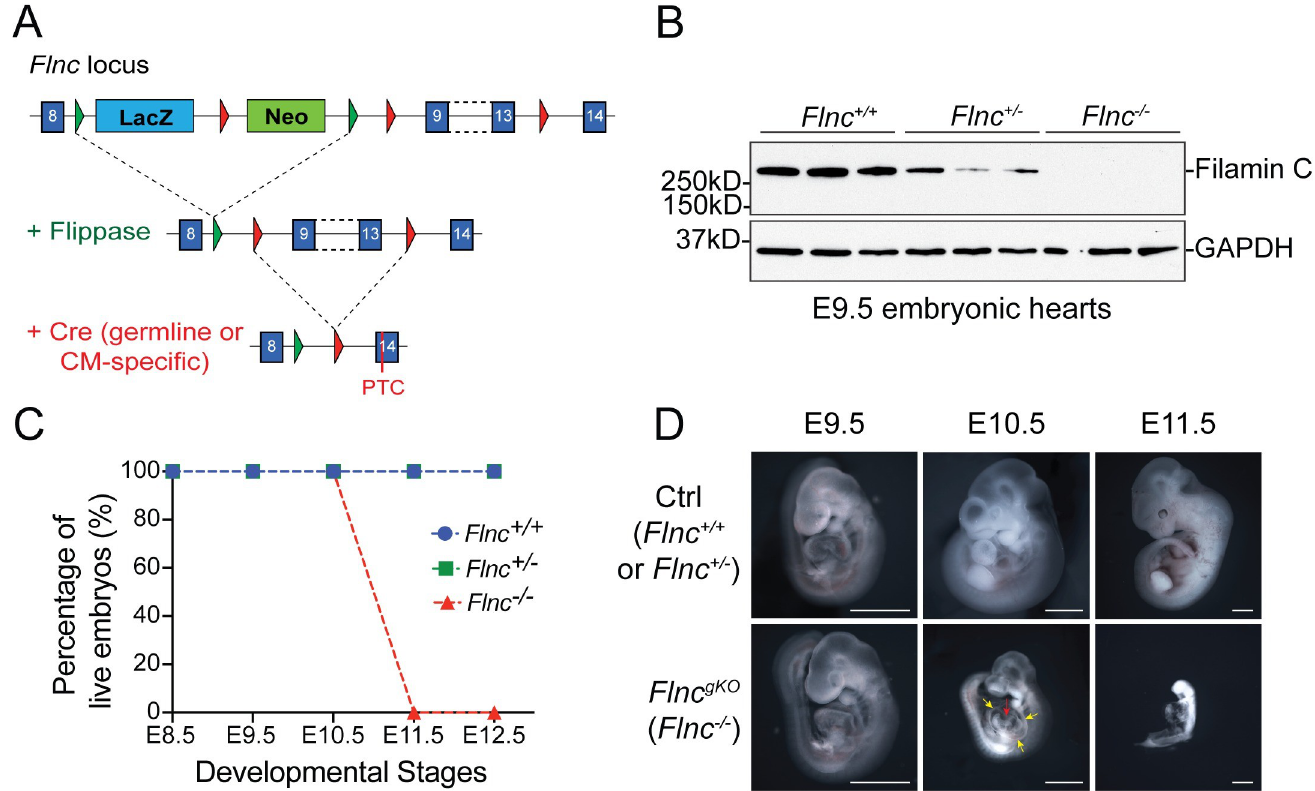
Fig 1. Filamin C is essential for mammalian heart development. ( A ) Targeting strategy for generating Flnc knockout mice. Global Flnc knockout mice were generated by crossing Flnc floxed mice ( Flnc fl/fl ) with Sox2 Cre mice, while cardiomyocyte-specific Flnc knockout mice were generated by crossing Flnc fl/fl mice with Xmlc2 Cre mice or cTnT Cre mice. After the deletion of exon 9–13 of the Flnc gene by Cre recombinase, a premature termination codon (PTC) will be introduced to exon 14 and trigger non-sense mediated mRNA decay (NMD) of Flnc mRNA. ( B ) Western blot confirms the complete depletion of filamin C protein in Flnc global knockout mice ( Flnc -/- or Flnc gKO ). GAPDH is used as a loading control. ( C ) Percentage of live wild-type ( Flnc +/+ ), heterozygous ( Flnc +/- ) and knockout ( Flnc -/- ) embryos from E8.5 to E12.5. Exact number of each genotype and each developmental stage: E8.5, 4:9:4 ( Flnc +/+ : Flnc +/- : Flnc -/- ); E9.5, 16:32:15; E10.5, 13:25:11; E11.5, 4:7:4 � ; E12.5, 4:6:0. � : dead/under resorption. ( D ) Wholemount images of control and Flnc global knockout ( Flnc gKO ) embryos at E9.5, E10.5 and E11.5. Yellow arrows indicate pericardial effusion; Red arrow indicates heart rupture; Scale bar, 1 mm.